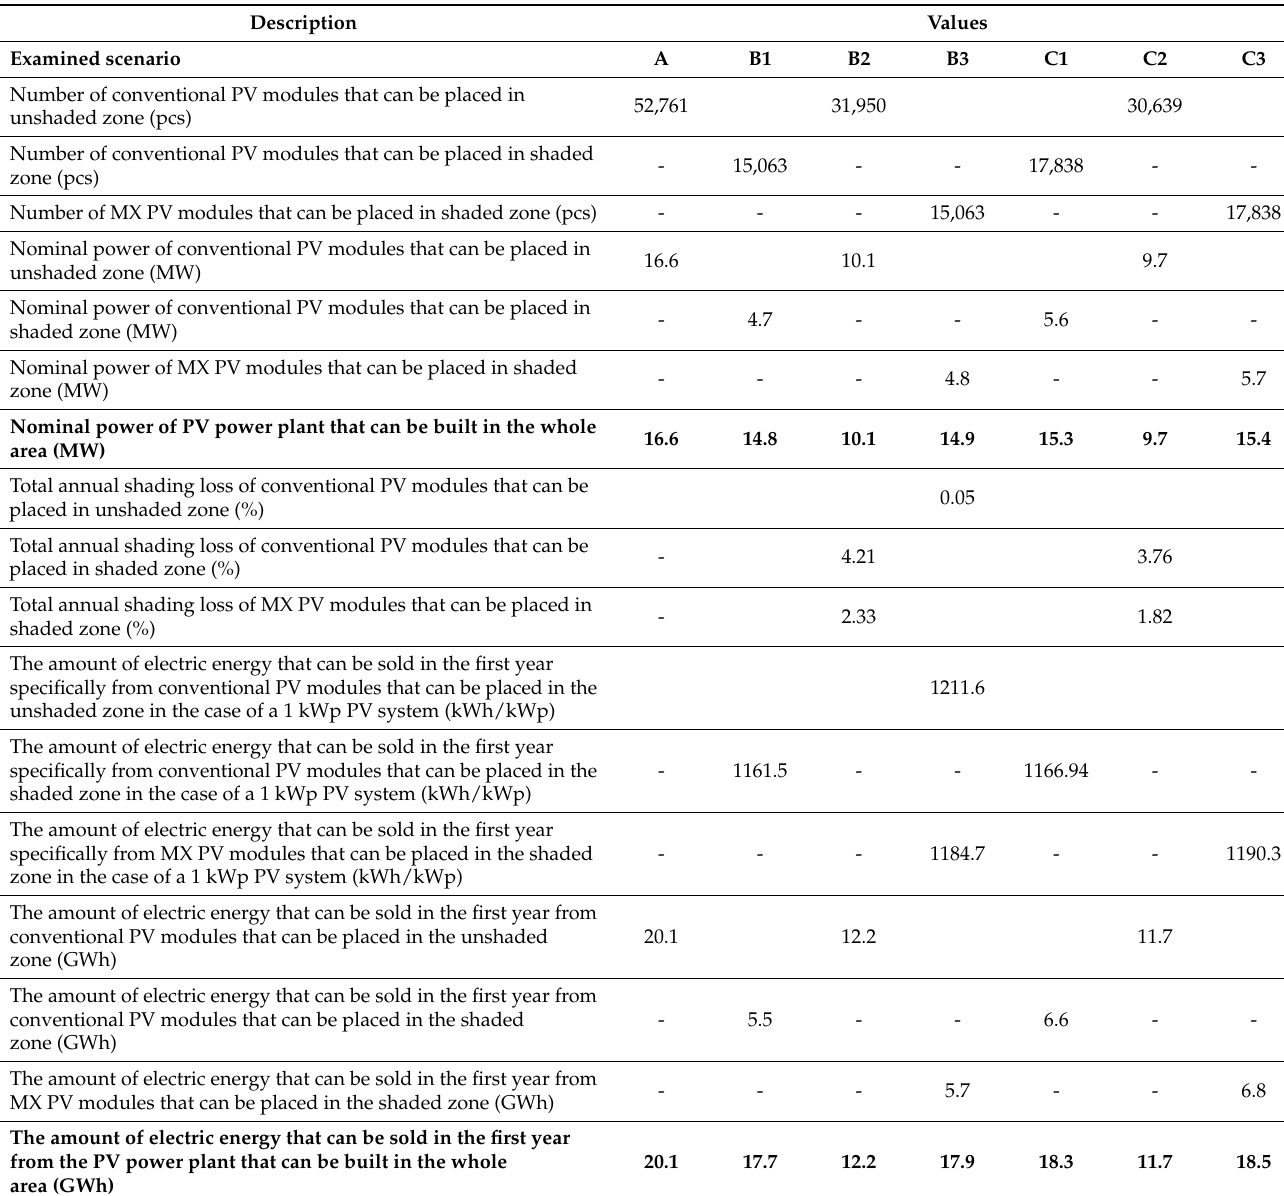
Table 6. Features of the PV power plants of the examined scenarios by the possible construction solutions of the conventional and MX PV